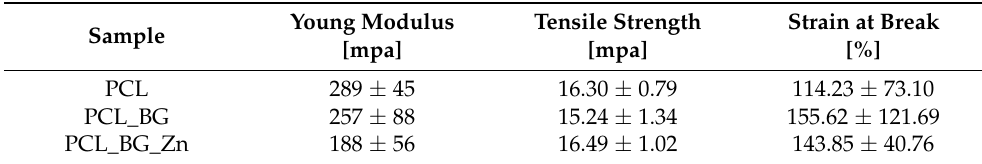
Table 3. Mechanical properties of PCL stick filaments: PCL, PCL_BG, PCL_BG_Zn.